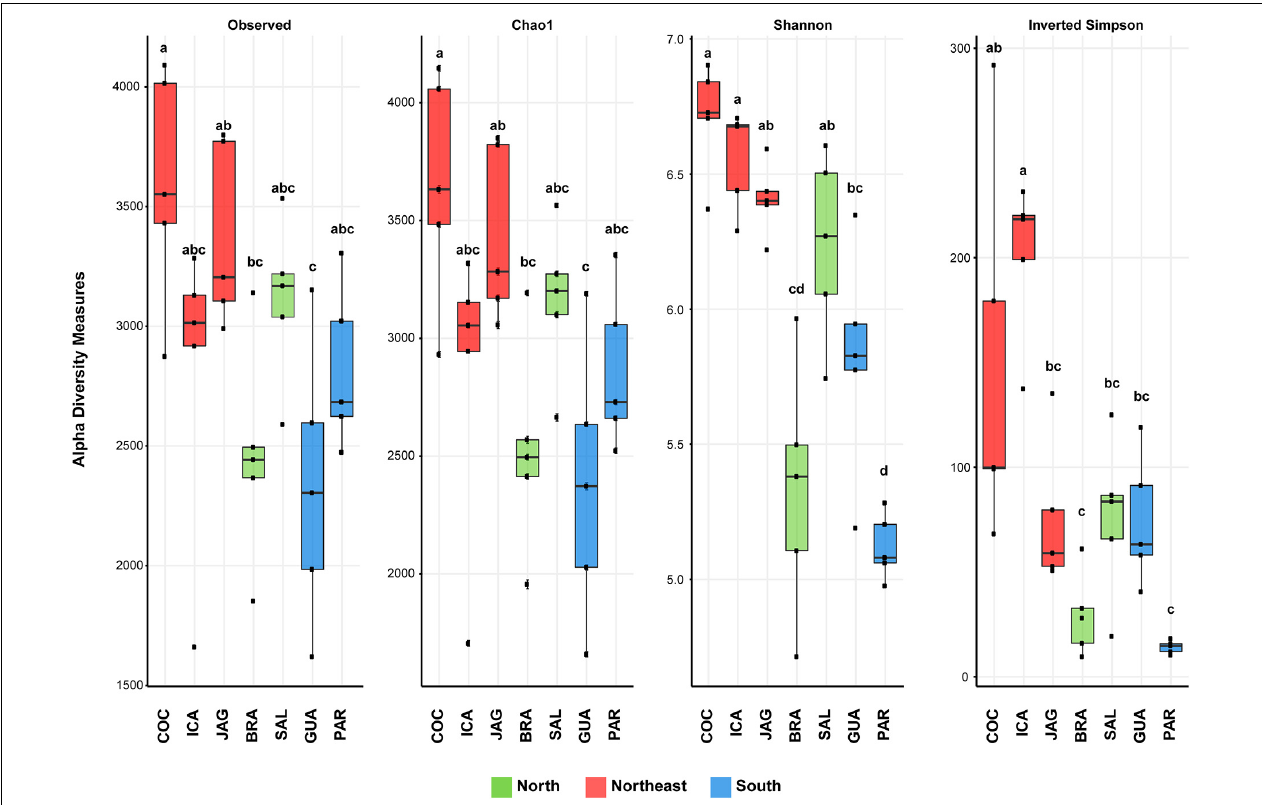
FIGURE 3 | Box plots showing the richness (Observed richness and Chao1) and alpha diversity (Shannon and Inverted Simpson indices) of microbial communities in the root zone of Rhizophora mangle from seven mangroves in the north (green), northeast (red), and south (blue) Brazilian regions. Taxonomic diversity is based on ASV level. Error bars represent the standard deviation of 15 independent replicates (five sampling points with three replicates from each mangrove). Different lowercase letters refer to significant differences between treatments based on Tukey’s HSD test ( P < 0.05) for the Shannon and Inverted Simpson indices and the Kruskal–Wallis test for Observed richness and